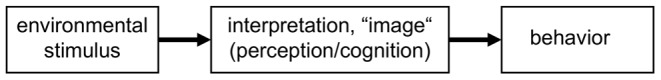
Behavioristic stimulus-response-model with perception component. (Source: adapted from [36]).